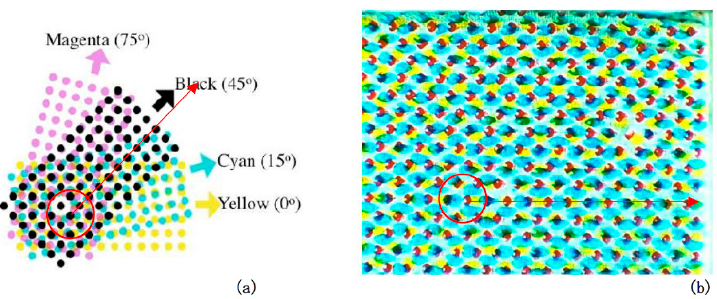
Figure 5. ( a ) Typical halftoning scheme for yellow (0°), cyan (15°), black (45°) and magenta (75°) (credit [1]). ( b ) Example of rosette pattern that may occur with another color halftoning scheme (with CMYK at 0° and a shift of few μ m along the X and Y axis).